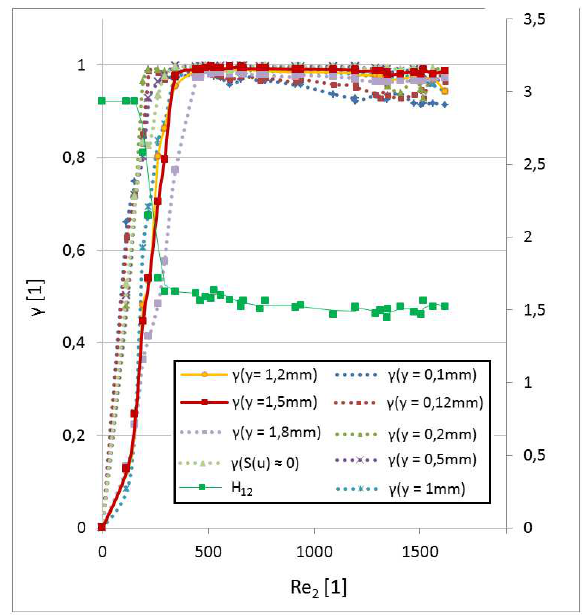
Fig. 7 . Intermittency factor and shape factor in different points of mean velocity profiles of boundqary layer, example. Position and size of identified transitional zone seem to be different. Plotted usingn Reynolds number Re 2 related to the momentum thickness δ 2 .